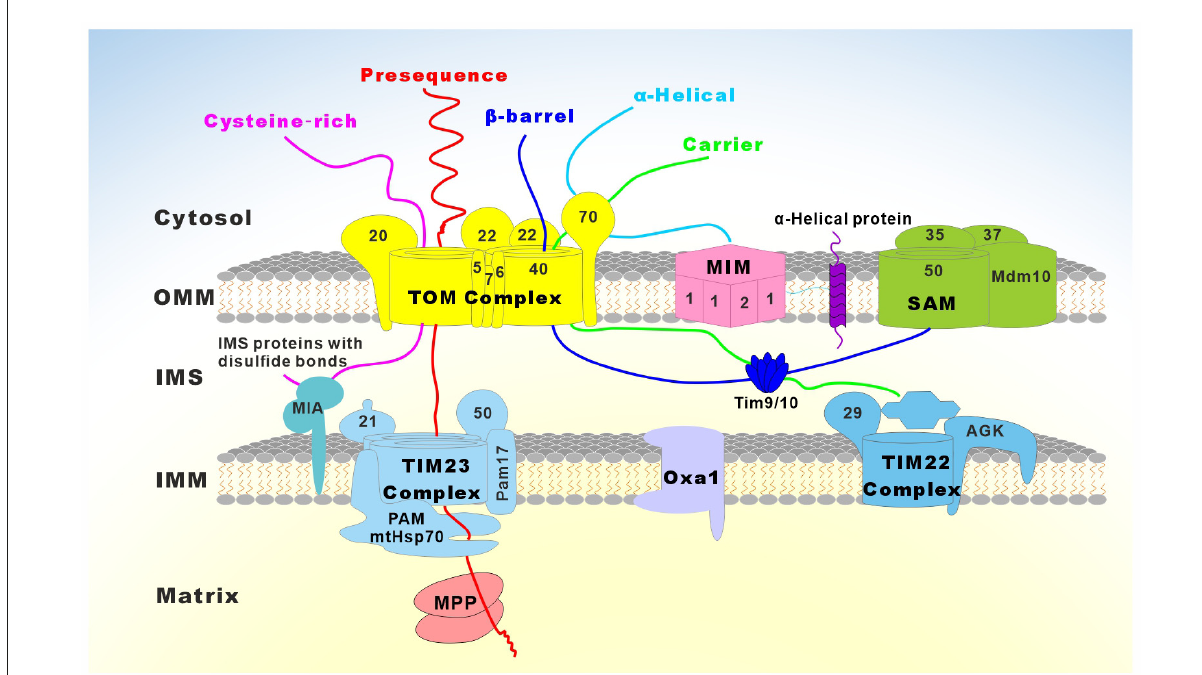
FIGURE6 Overview of the major mitochondrial protein import pathways. Mitochondrial precursor proteins are synthesized in the cytosol, transported to the mitochondria, and directed to the correct mitochondrial compartments. Five major protein import pathways have been identified so far: (1) Presequence-carrying preproteins are imported through the translocase of the outer mitochondrial membrane (TOM) and the translocase of theinner mitochondrialmembrane(TIM23)complexes. Proteinscontaininga hydrophobicsortingsignalare releasedintotheinner mitochondrial membrane (IMM), while hydrophilic proteins are imported into the matrix with the help of the presequence translocase-associated motor (PAM) complex. Membrane potential across the IMM is essential for the entry of presequences into the matrix. The presequences are cleaved by the mitochondrial processing peptidase (MPP) and additional proteolytic processing occurs by intermediate cleaving peptidases. Presequence- carrying precursors that are integrated into the IMM are either directly released from the TIM23 complex or transported into the matrix, followed by further insertion into the IMM with the help of Oxa1; (2) Cysteine-rich proteins of the intermembrane space (IMS) are imported by TOM and the mitochondrial IMS import and assembly (MIA) system, which inserts disulfide bonds in the imported proteins; (3) The precursors of β -barrel proteins are translocated through the TOM complex to the TIM9/10 in the IMS and are inserted into the outer mitochondrial membrane (OMM) by the sorting and assembly machinery (SAM); (4) The precursors of metabolite carriers of the IMM are imported via the TOM complex, small TIM9/10 chaperones, and the carrier translocase TIM22 complex; and (5) Some proteins with α -helical transmembrane segments are inserted into the OMM by the mitochondrial import (MIM)